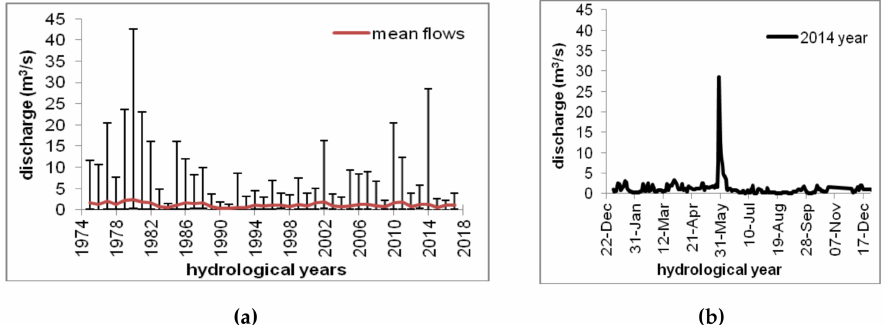
Figure 2. Variability of discharge at the Posoka gauge station, ( a ) for the period 1971–2017; ( b ) for the year